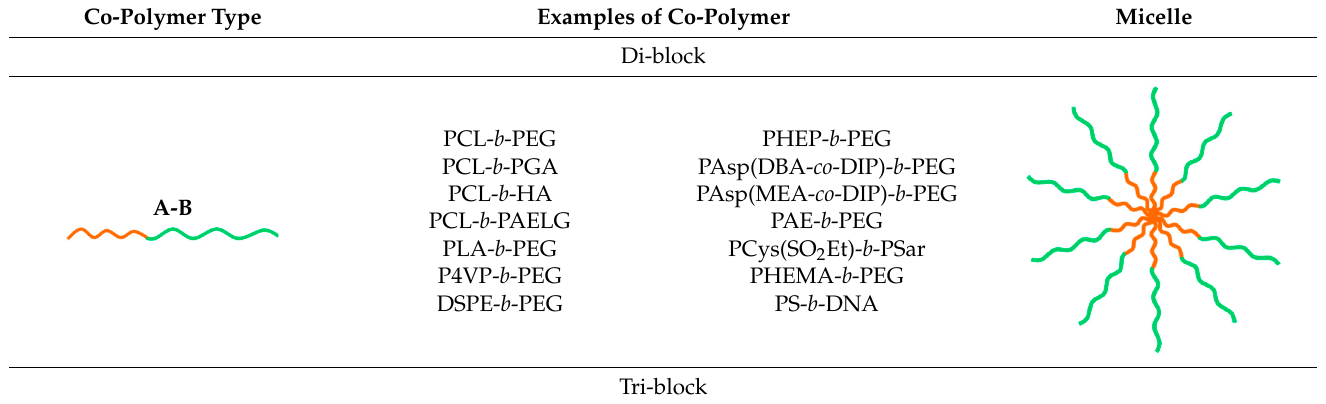
Table 2. Self-assembly architectures of amphiphilic copolymers to produce magnetic micelles. Co-Polymer